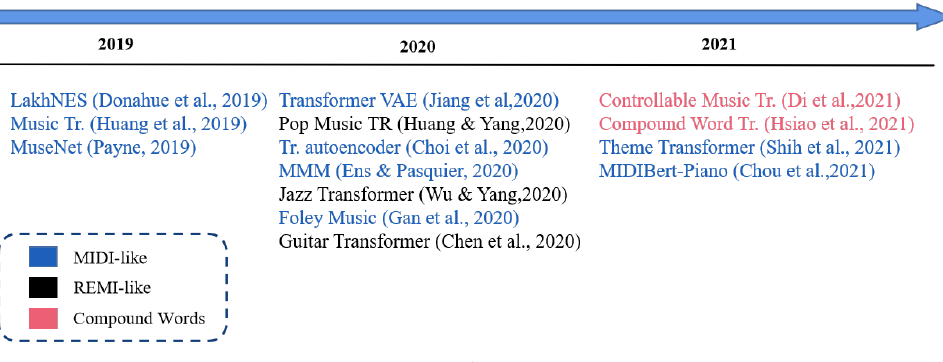
Figure 1. Ways to represent music in recent